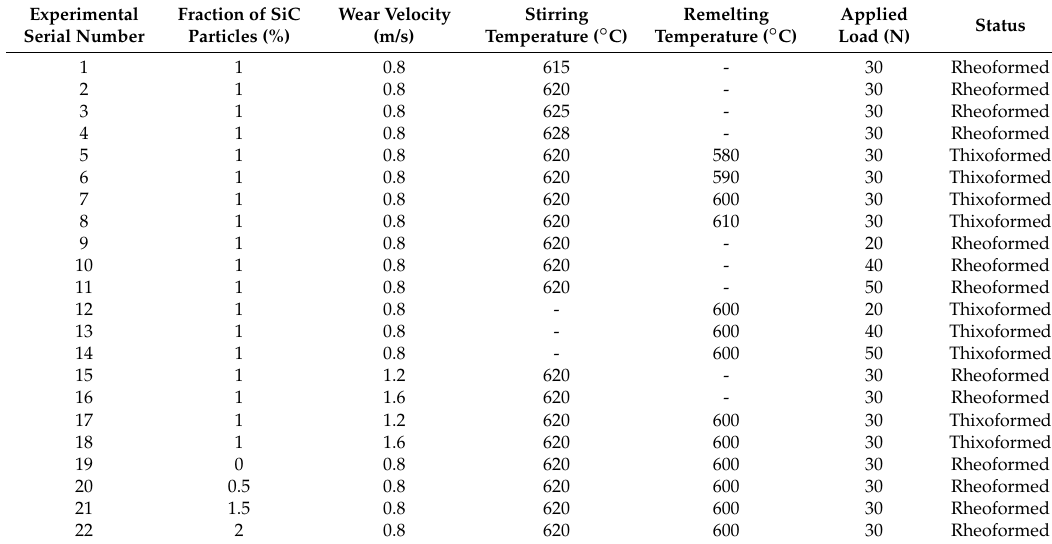
Table 1. Experimental procedures of dry sliding wear tests of nano-sized SiCp/7075 composite parts fabricated by rheoforming and thixoforming. Experimental Fraction of SiC Wear Velocity Serial Number Particles (%)